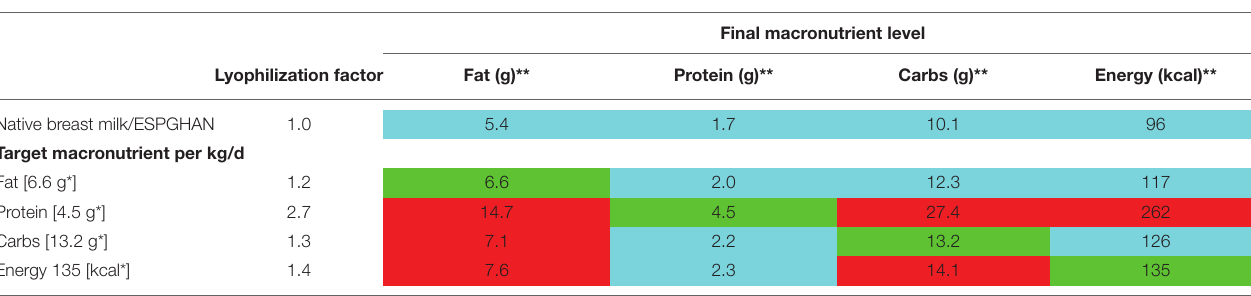
TABLE 7 | Macronutrient levels in native breast milk (BM) in 150mL fluid intake.